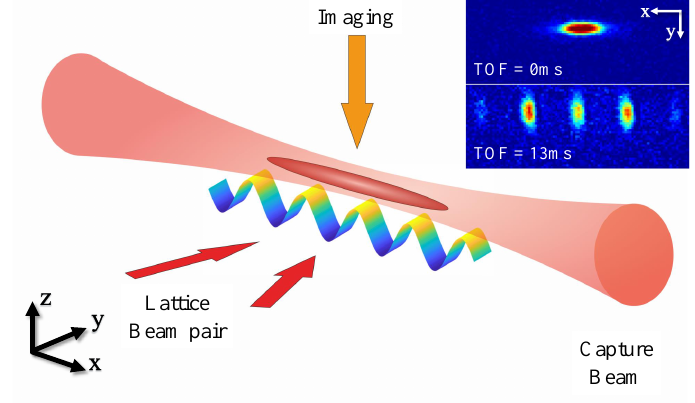
Figure 1: Schematic of the experimental setup with images taken before and after